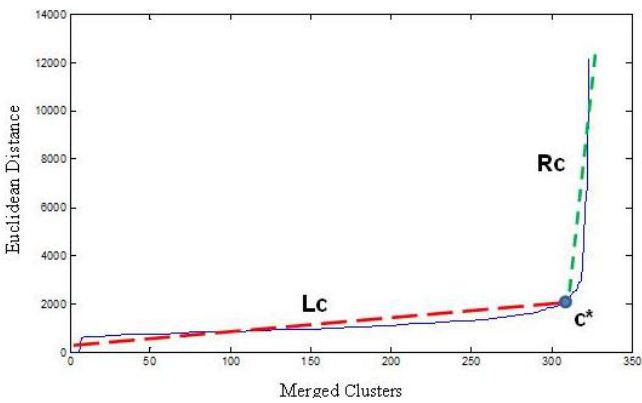
Figure 1. Determining number of clusters using critical point “ c *